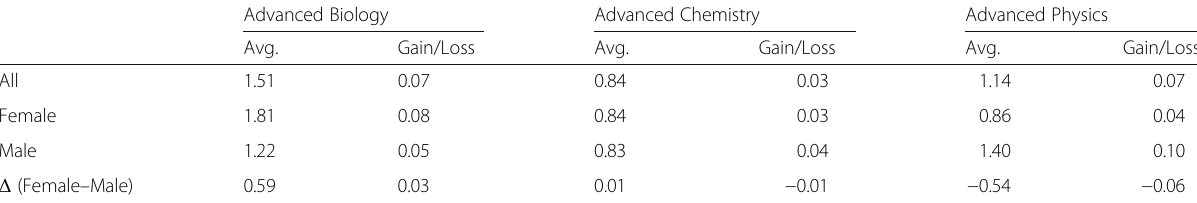
Table 9 Six-year average enrollment rates and gain/loss of enrollment rates by gender in advanced biology, advanced chemistry, and advanced